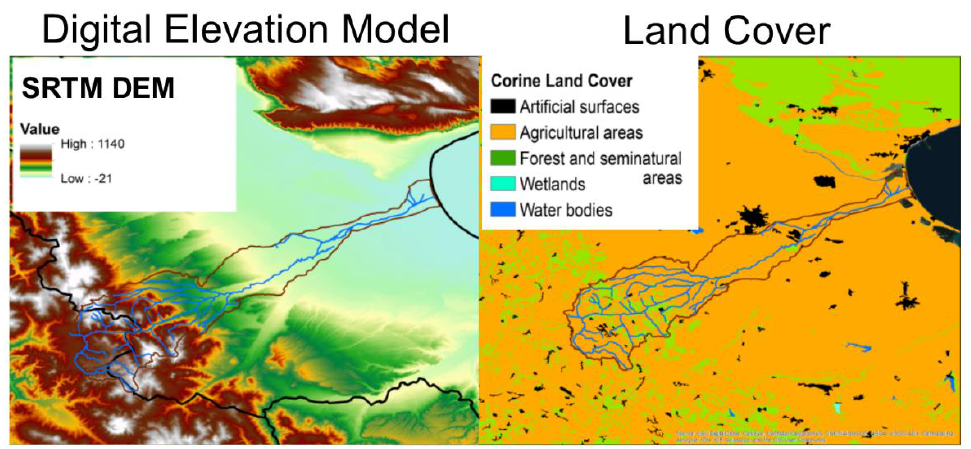
Figure 2. Left panel: topography of the Cervaro Basin represented by means of the Shuttle Radar Topography Mission (SRTM) Digital Elevation Model (DEM), SpR: 30 m; right panel: land cover map (Corine Land Cover 2012).